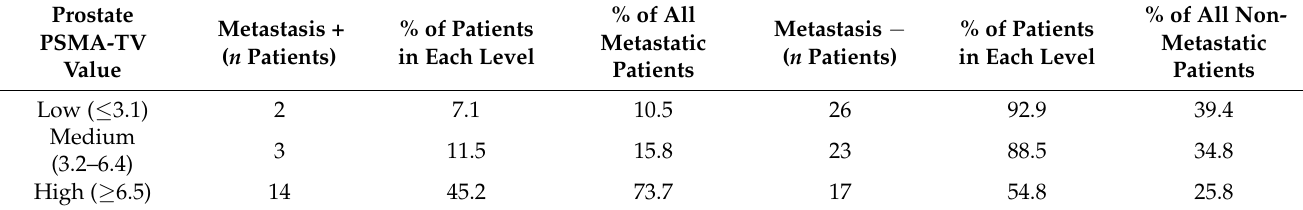
Table 5. Relationship between prostate PSMA-TV levels and metastases